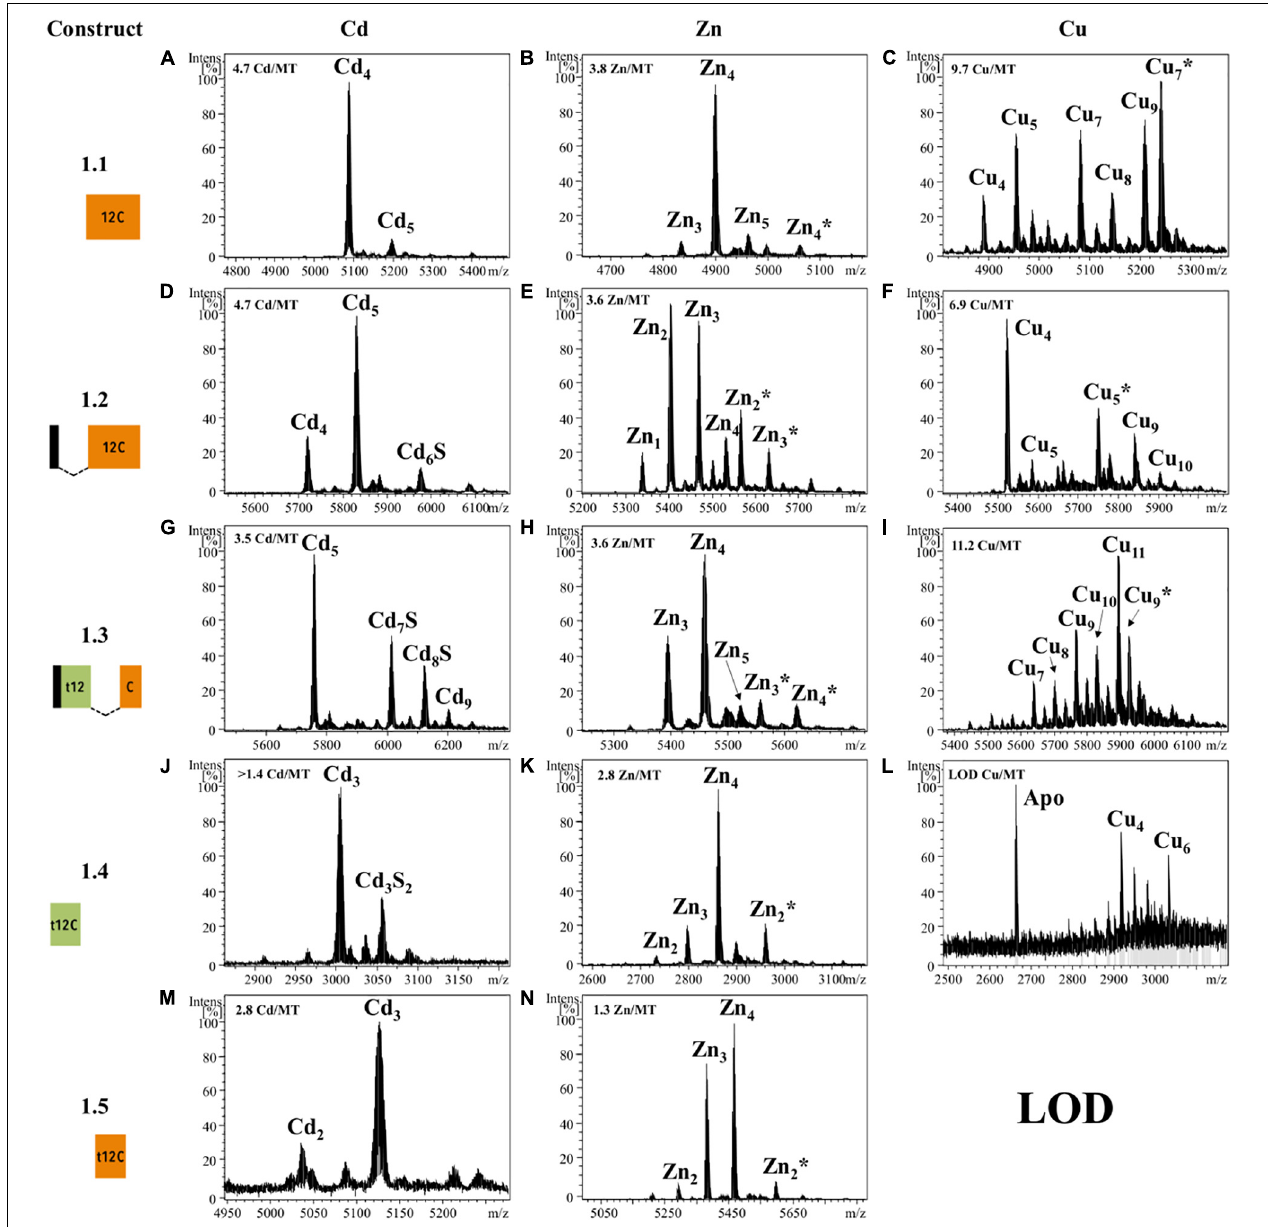
FIGURE 2 | Deconvoluted ESI-MS spectra recorded at pH 7.0 of OdiMT1 constructs 1.1 (A–C) , 1.2 (D–F) , 1.3 (G–I) , 1.4 (J–L) , and 1.5 (M,N) bioproduced with Cd (A,D,G,J,M) , Zn (B,E,H,K,N) , or Cu (C,F,I,L) . Y -axis represents the relative intensities of the peaks while the X -axis represents the m/z ratio equivalent to the MW (Da). The metal-to-protein ratio obtained by ICP-AES is included on the top left of each panel. It is indicated those cases in which the sample concentration was lower than the limit of detection (LOD). Glycosylated species are marked with an asterisk